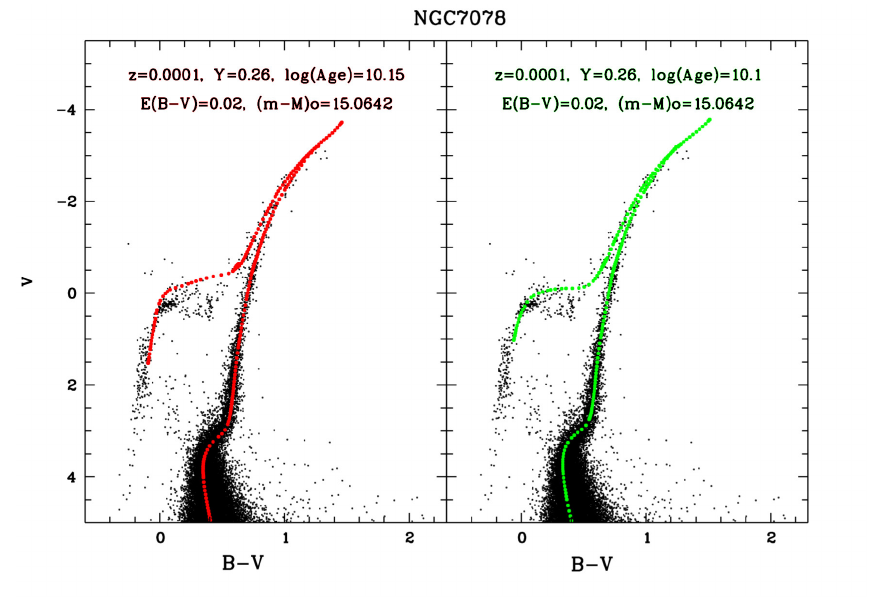
Fig. 1. I vs. V { I diagram for NGC 7078 (Piotto et al. 2002) with isochrones from Bertelli et al. (2009) overlaid. Left: isochrone with log(Age) = 10 : 15, Y = 0 : 26, Z = 0 : 001, the values used by us for spectral (cid:12)tting. Right: isochrone with log(Age) = 10 : 10, Y = 0 : 26 and Z = 0 : 0001, the values used by Vandenberg et al.